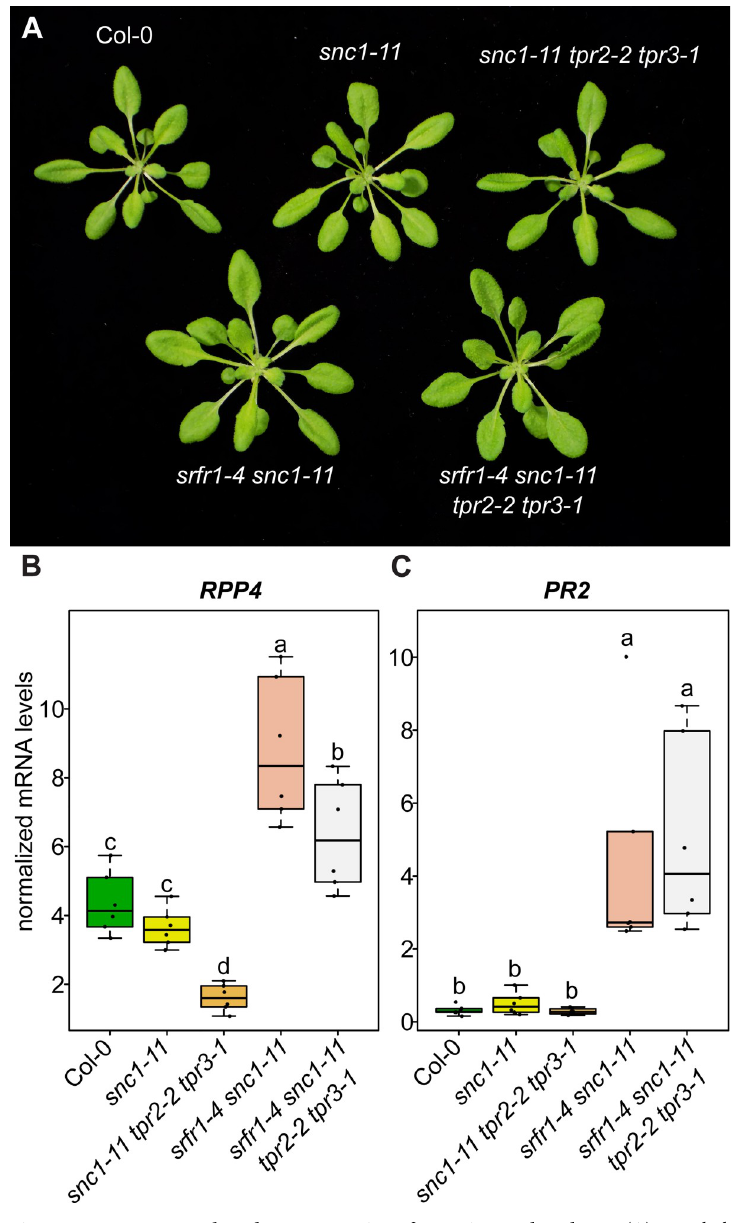
Fig 6. tpr2 tpr3 mutants have lower expression of RPP4 in snc1 knockouts. (A) Morphological phenotype of plants harboring the snc1-11 mutation crossed into srfr1 and tpr2 tpr3 mutants. Plants were grown under short day conditions at 21˚C for four weeks. (B&C) Expression as measured by quantitative RT-PCR of RPP4 and PR2 . Dots represent individual data points taken over two separate experiments. Genes of interest were normalized against SAND (At2g28390). Whiskers on boxplots are drawn to the farthest data point within 1.5 � IQR of first and third quartiles. Letters denote significant differences as determined by Student’s t-test ( P < 0.05) using the Bonferroni-Holm method to correct for multiple